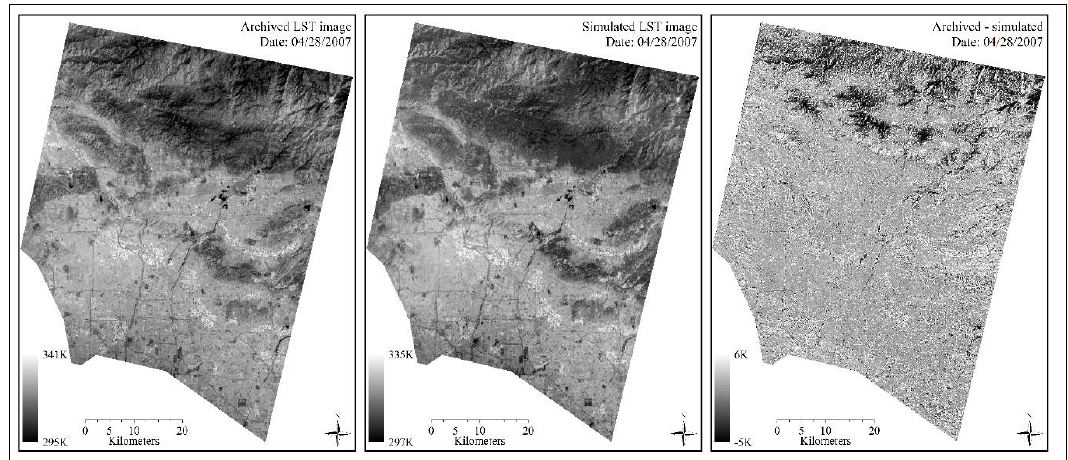
Figure 3. A comparison between observed ( left ) and simulated ( middle ) ASTER LST image on date 04/28/2007. The map ( right ) shows the difference between observed and simulated images. Spatial resolution: 90 m.